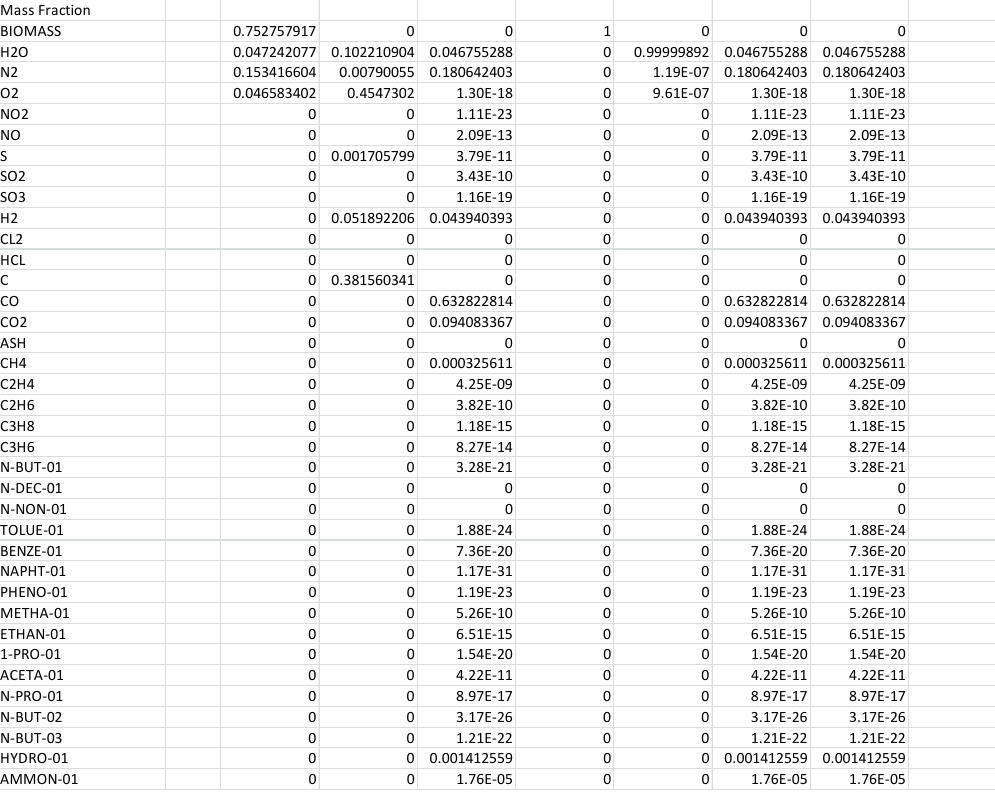
Figure A9. Gasification stream results (part 2—mass fractions).